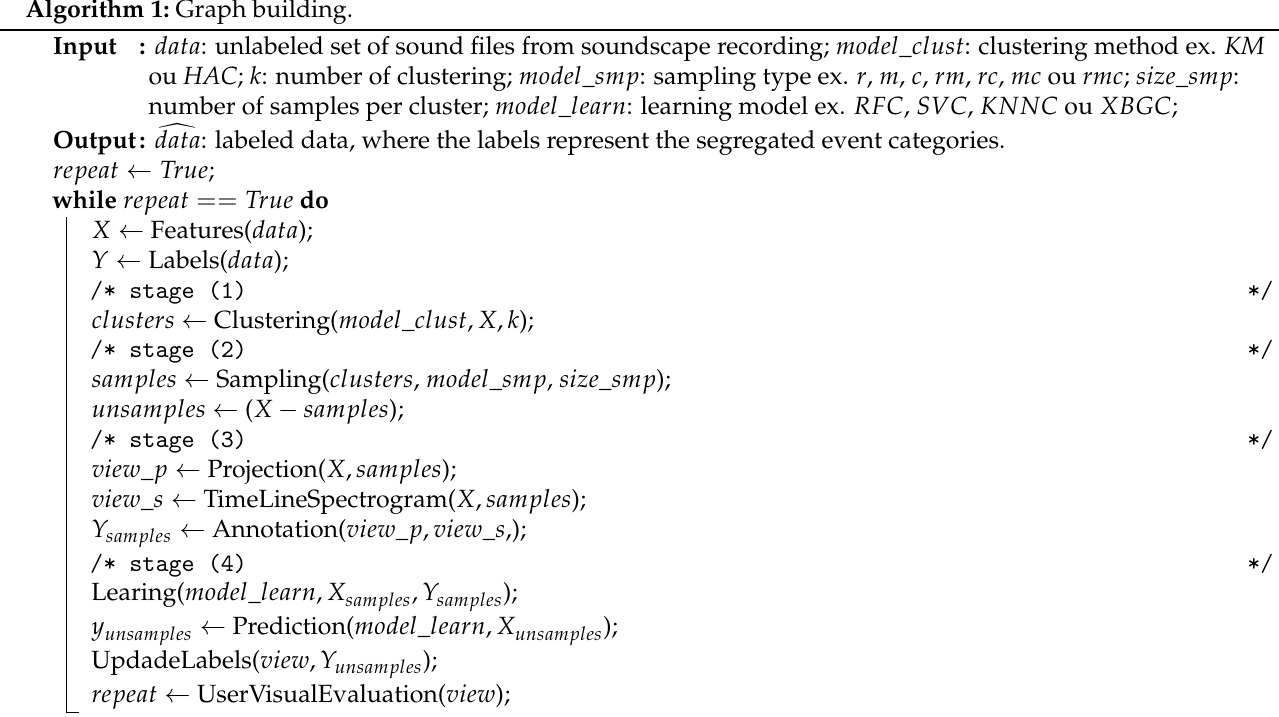
Figure 1. Framework of the proposed method: visual active learning for labeling data. Algorithm 1: Graph